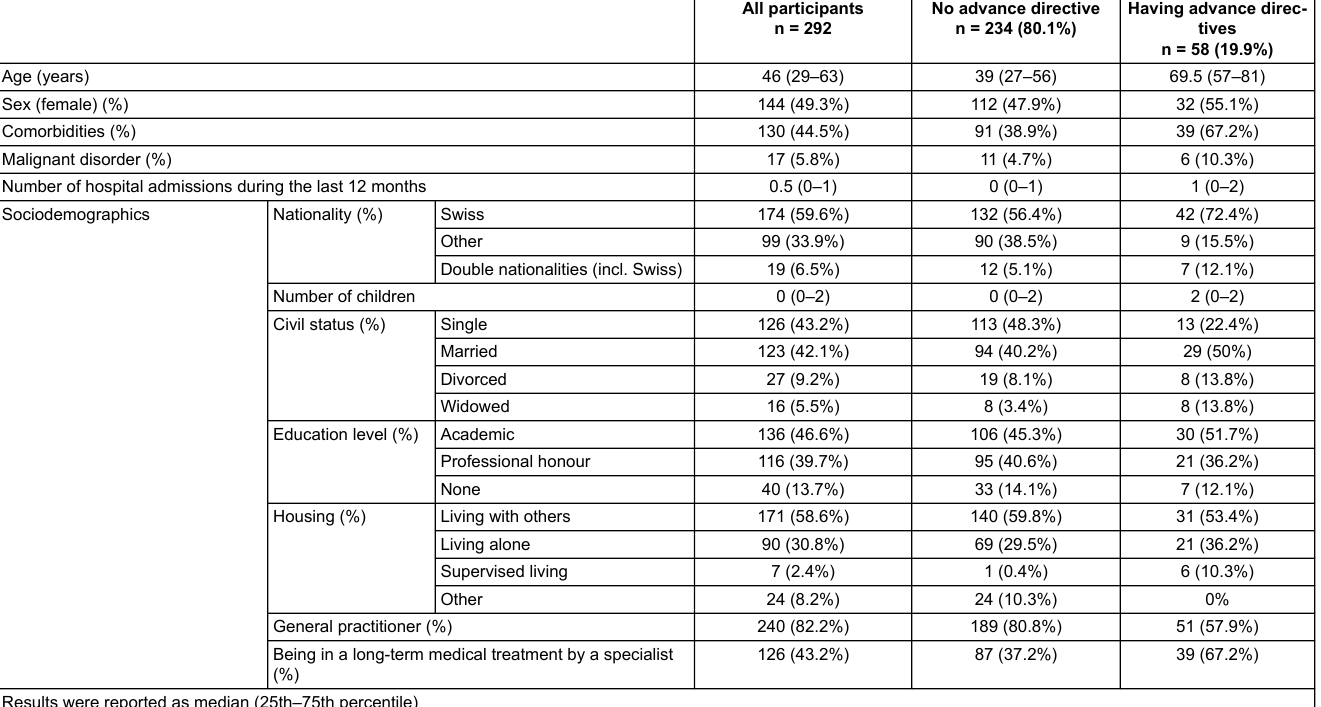
Table 1: Participants’